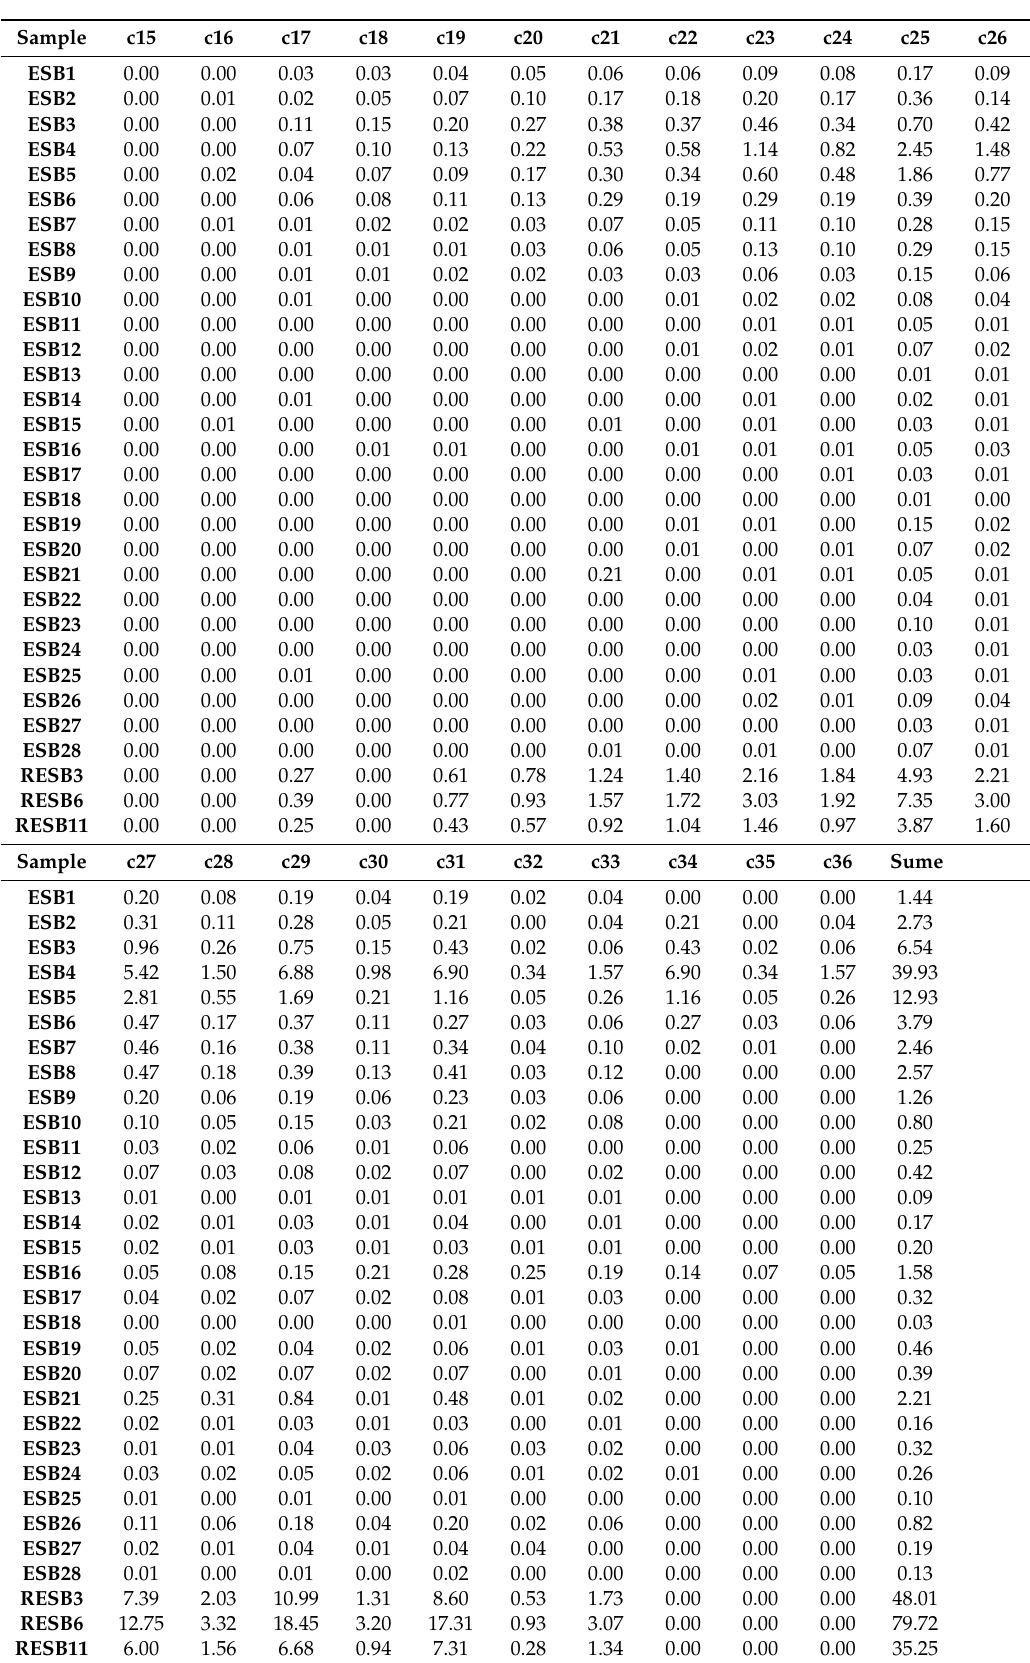
Table 6. n -alkanes content ( µ g/g) of the samples